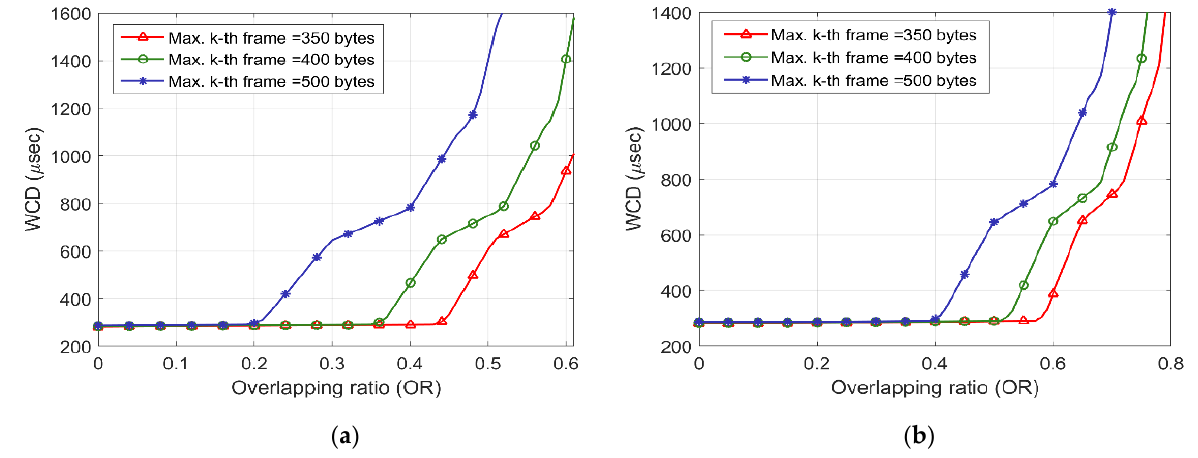
Figure 15. WCD vs. higher-priority overlapping with different sizes of the fourth-priority frame ((cid:1858) (cid:2872)(cid:3040)(cid:3028)(cid:3051) ): ( a ) opening-edge overlapping and ( b ) closing-edge overlapping.